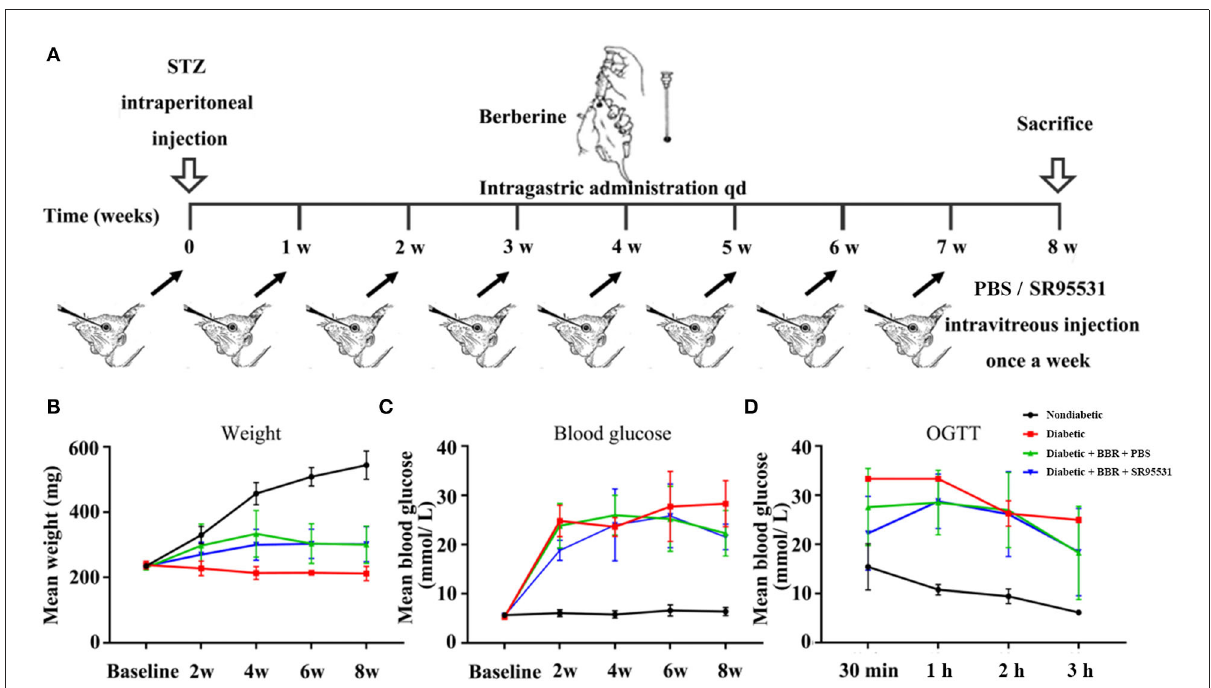
FIGURE3 Scheme of model establishment and the conditions of rats in all groups. (A) Scheme of experimental diabetic model rat establishment, and BBR and SR95531 administration. (B) The body weights of rats in the non-diabetic group, diabetic group, diabetic + BBR + PBS group, and the diabetic + BBR + SR95531 group measured at baseline and at 2 weeks, 4 weeks, 6 weeks, and 8 weeks after STZ injection. (C) The blood glucose levels of rats in the non-diabetic group, diabetic group, diabetic + BBR + PBS group, and the diabetic + BBR + SR95531 group measured at baseline and at 2 weeks, 4 weeks, 6 weeks, and 8 weeks after STZ injection. (D) Oral glucose tolerance test (OGTT) results of rats in the non-diabetic group, diabetic group, diabetic + BBR + PBS group, and the diabetic + BBR + SR95531 group measured at 8 weeks after STZ